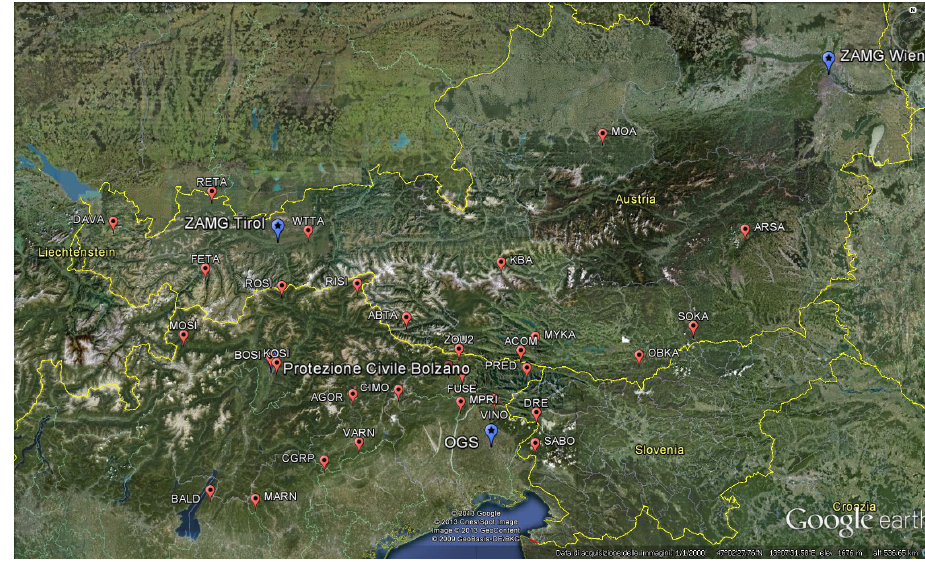
Figure 2. Map of seismic stations in red and data centers in blue involved in the SeismoSAT project.